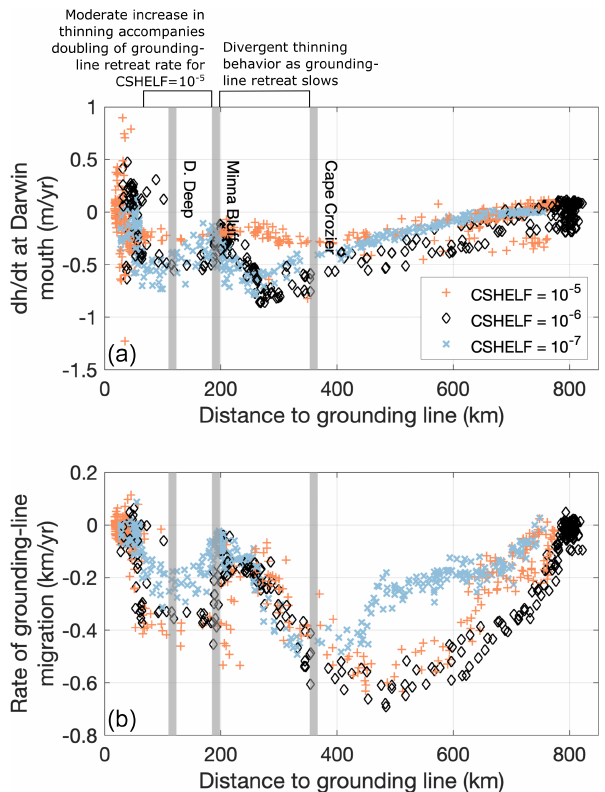
Figure 9. Results from the 48-member PSUICE ice sheet model en- semble. (a) The relationship between rate of ice thickness change at the mouth of Darwin Glacier and the distance to the grounding line for all ice sheet model runs. The basal sliding parameter (CSHELF) has by far the largest effect of the parameters we explored in the ensemble. Gray bars indicate the locations of the features we hy- pothesized to affect the rate of grounding-line retreat: Cape Crozier, Minna Bluff, and the Discovery Deep. (b) Grounding-line migra- tion rate as a function of distance to the grounding line from Dar- win Glacier. Negative values indicate retreat. Retreat slows after the grounding line retreats past Cape Crozier, but thinning rates at Dar- win Glacier increase or slightly decrease, depending on the value of the basal sliding parameter. Grounding-line migration acceler- ates significantly after the grounding line has retreated past Minna Bluff. Perhaps counterintuitively, the acceleration of grounding-line retreat into the back-sloping Discovery Deep is not always accom- panied by increased thinning rates at the mouth of Darwin Glacier. This indicates that there might not be a large thinning signal in glacial deposits near the mouth of Darwin Glacier, even for a very rapid pulse of grounding-line